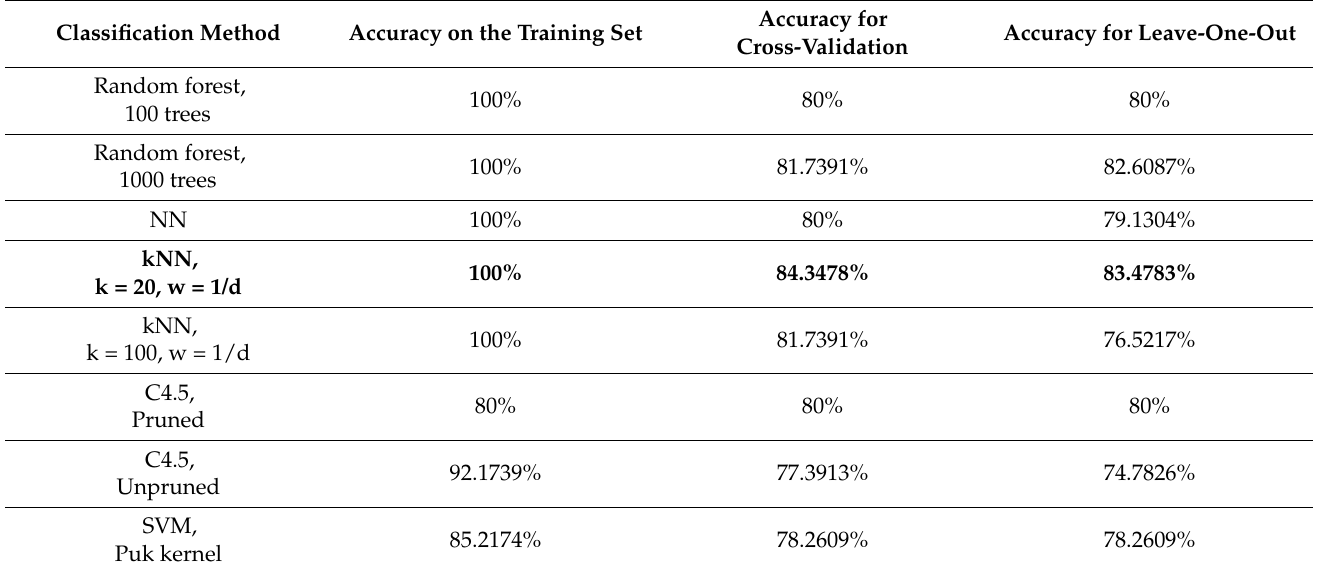
Table 7. Classification results for all records in the